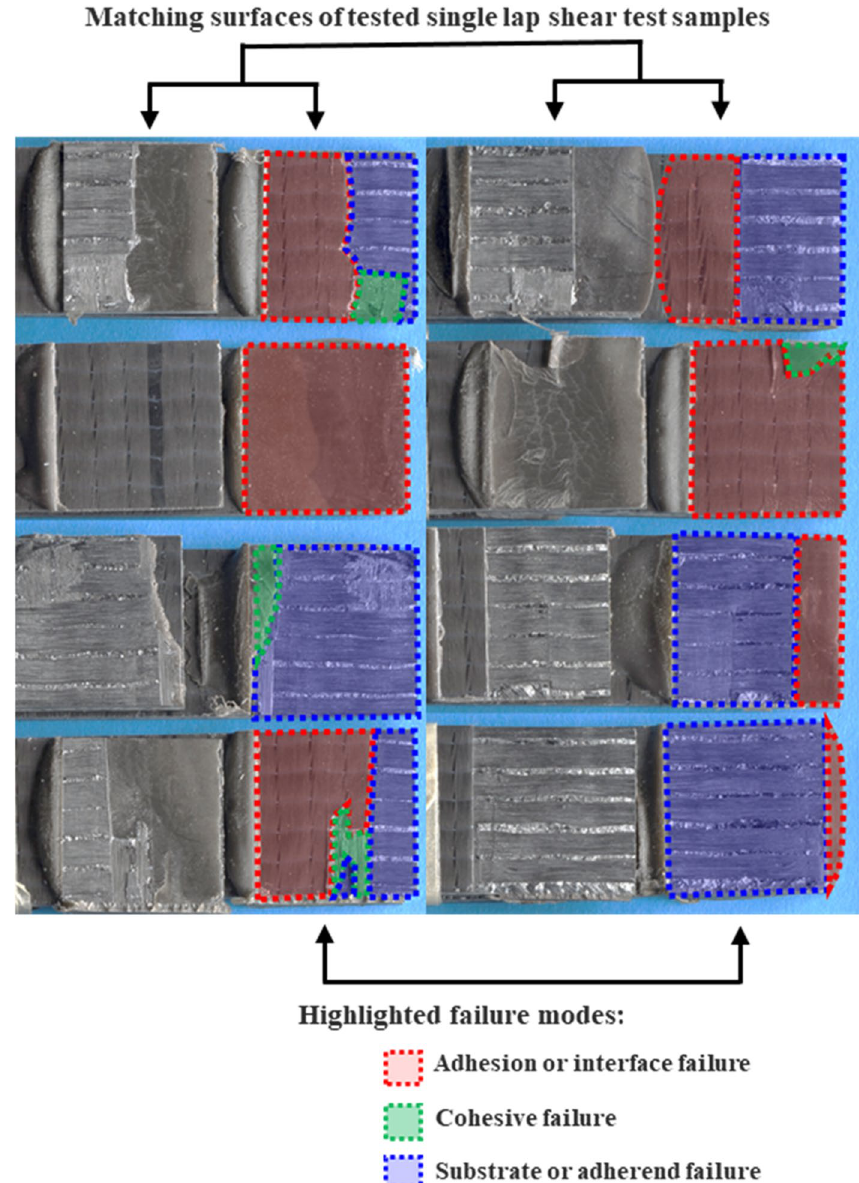
Fig. 3 Variation in the failure mode of eight single lap shear test samples manufactured and tested under the same conditions. Copyright © 2021 TWI Ltd. reproduced